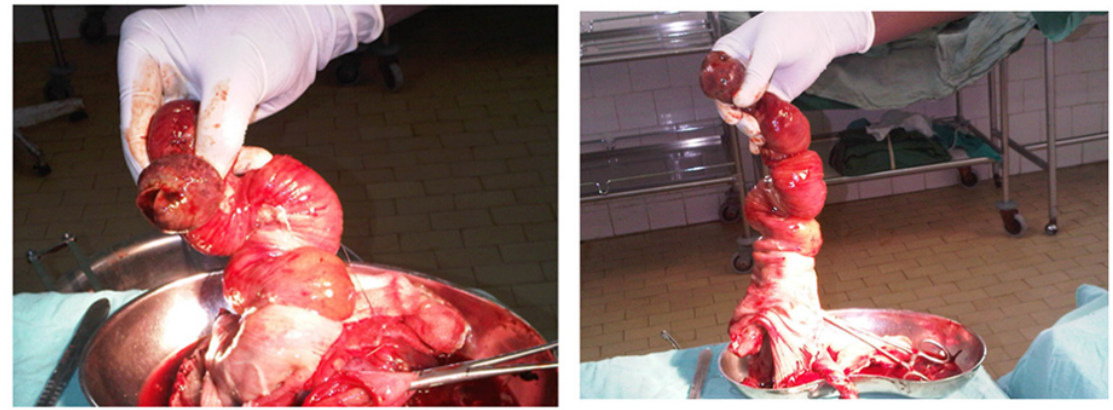
Figure 2. Mid jejunum with a leading tumor.